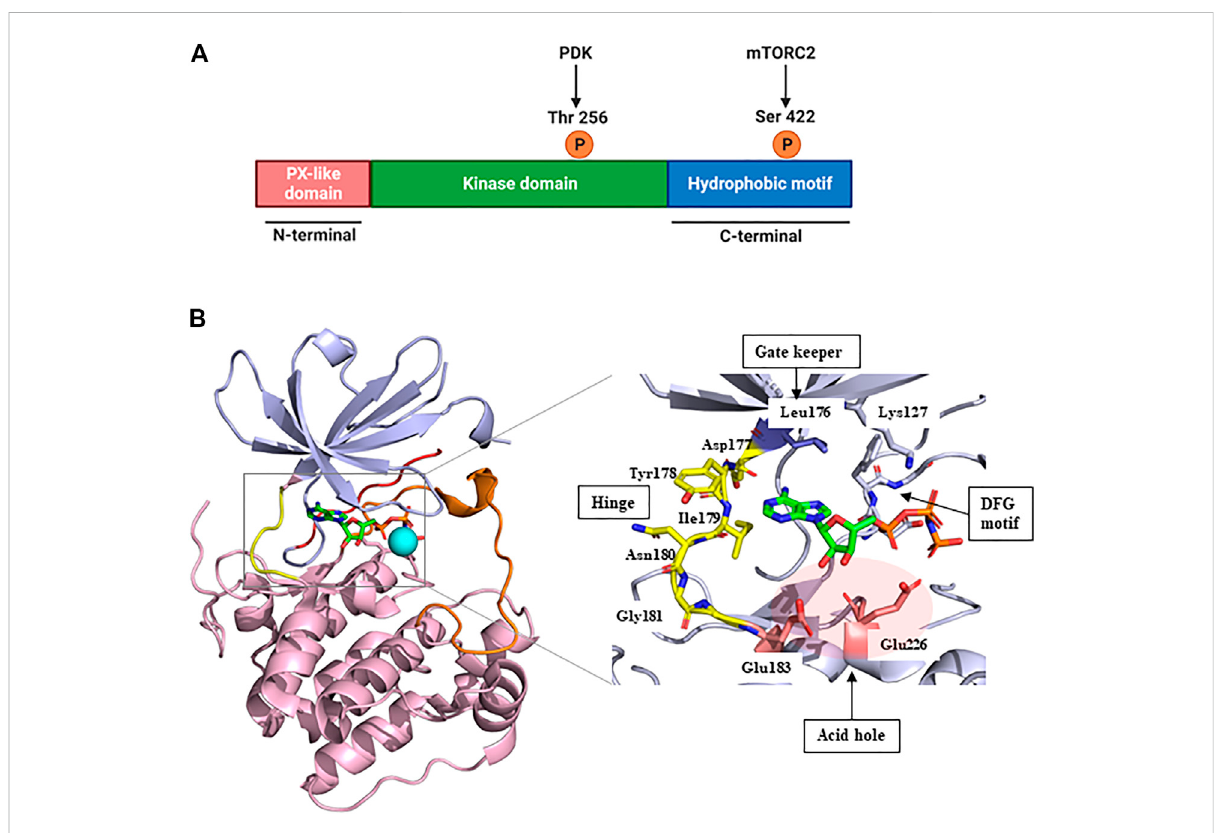
FIGURE 1 Structure ofSGK1. (A) Theproteindomain structureofSGK1.SGK1consistsofanN-terminal PX-likedomain,akinasedomain,andaC-terminal hydrophobic motif. The activity of SGK1 is governed by 2-step phosphorylation: 1) Extracellular stimuli induce mTORC2 activation, which phosphorylates Ser 422 at the hydrophobic motif. 2) PDK1 is recruited to the phospho-Ser, and transfers phosphate group to Thr 256 at the kinase domain. This fi gure was created using BioRender. (B) Three-dimensional (3D) structure of SGK1 kinase domain (left) and the details of ATP- bindingsite(right).mTORC2,mammaliantargetofrapamycincomplex2;PDK1,phosphatidylinositide-dependentproteinkinase1;SGK1,serum and glucocorticoid-regulated kinase